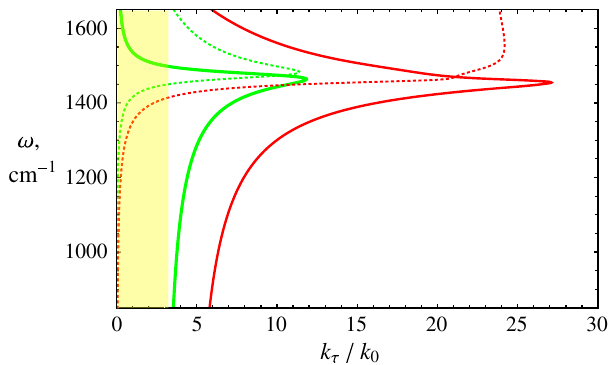
FIG. 14. Surface states at the interface of a semiconductor hypercrystal with air (same as in Fig. 13), taking into account the actual material absorption, for orders zero (green) and one (red). Solid and dashed lines correspond, respectively, to the real and imaginary parts of the in-plane momentum of the surface modes, while the translucent yellow region corresponds to the light cone of the dielectric that borders the hypercrystal k τ <